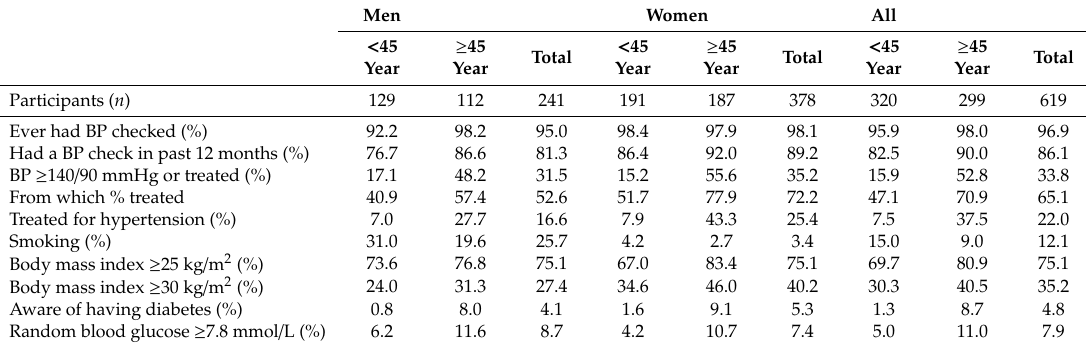
Blood pressure (BP) estimates are based on the average of three readings.